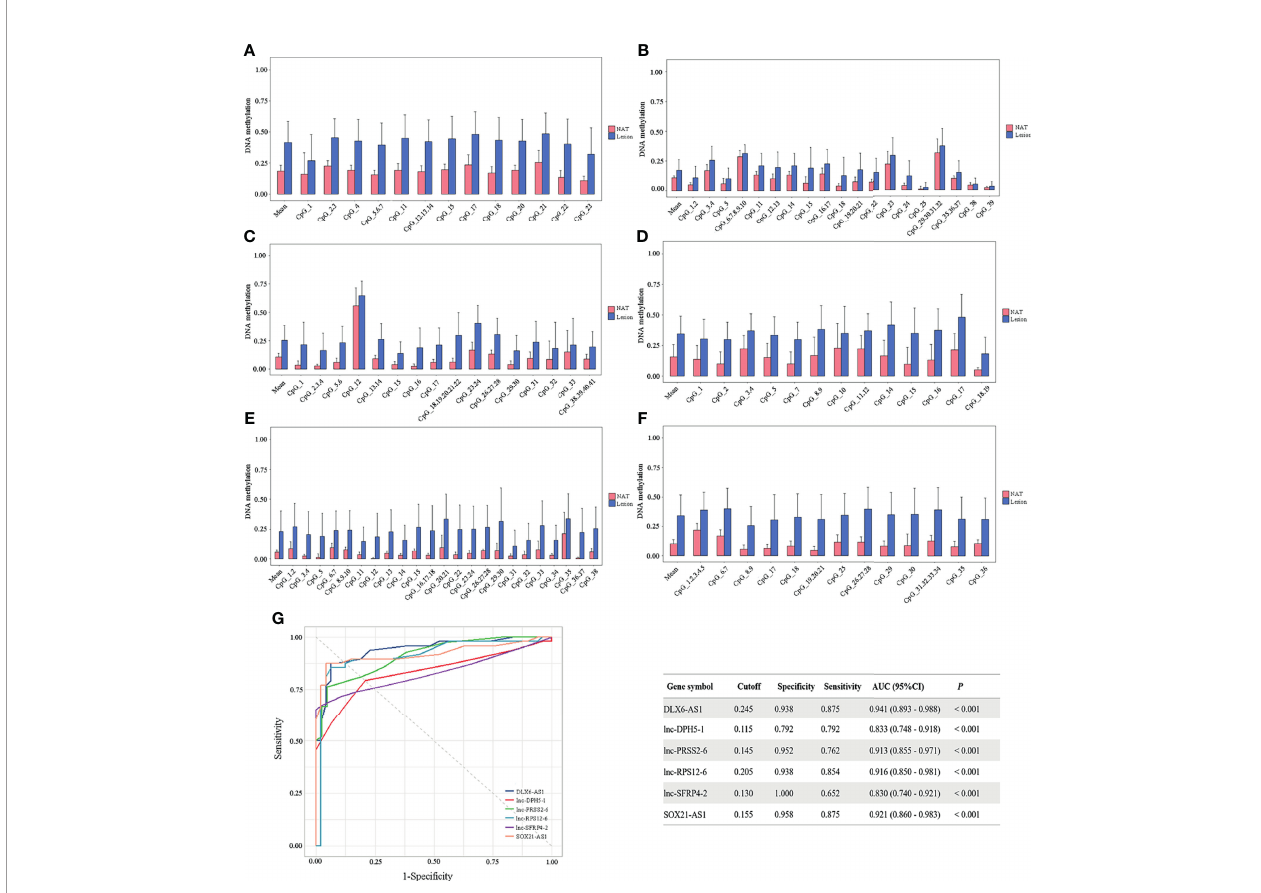
FIGURE 4 | Methylation status of six selected candidates quanti fi ed by MassARRAY EpiTYPER among CRC patients in cohort II. Quanti fi cations are shown for methylation levels of (A) DLX6-AS1 , (B) lnc-DPH5-1 , (C) lnc-PRSS2-6 , (D) lnc-RPS12-6 , (E) lnc-SFRP4-2 and (F) SOX21-AS1 . (G) The discriminative ability of the six selected genes between CRC tissues and adjacent normal tissues by ROC analysis. NAT, histologically normal tissue adjacent to the